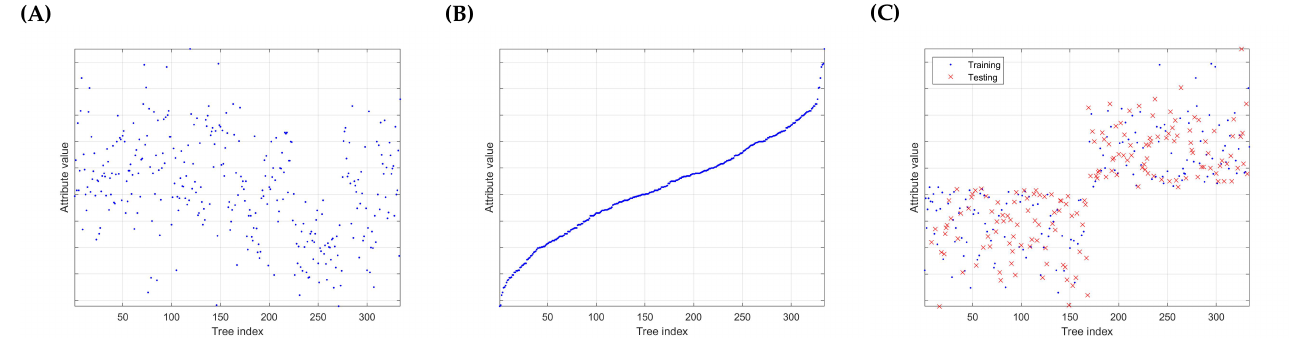
Figure 2. ( A ): The y axis depicts the values of the tree attribute (DBH, stem volume, ∆ DBH, or ∆ stem volume) used as target values. Here, the data are not in any specific order. ( B ): The values are sorted in increasing order. ( C ) The data are divided into two intervals, which are then shuffled internally. In every interval, a 50/50% testing-training split is made, which is depicted in blue and red. One fold of the two-fold cross-validation, which Panel ( C ) represents, then goes through both the intervals and picks the assigned testing-training samples for the prediction. This process is repeated twice, choosing different samples for testing and training to finish the two-fold cross-validation and capture all the values in the test